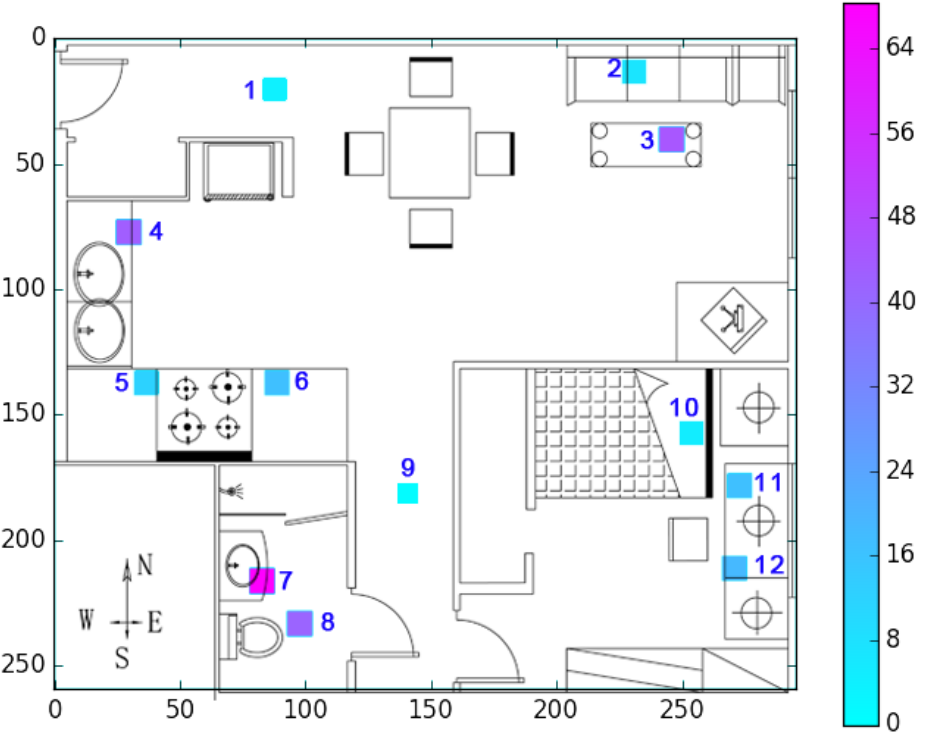
Figure 6. Real-life data captured. The squares with different colors are the testing points with different illumination.